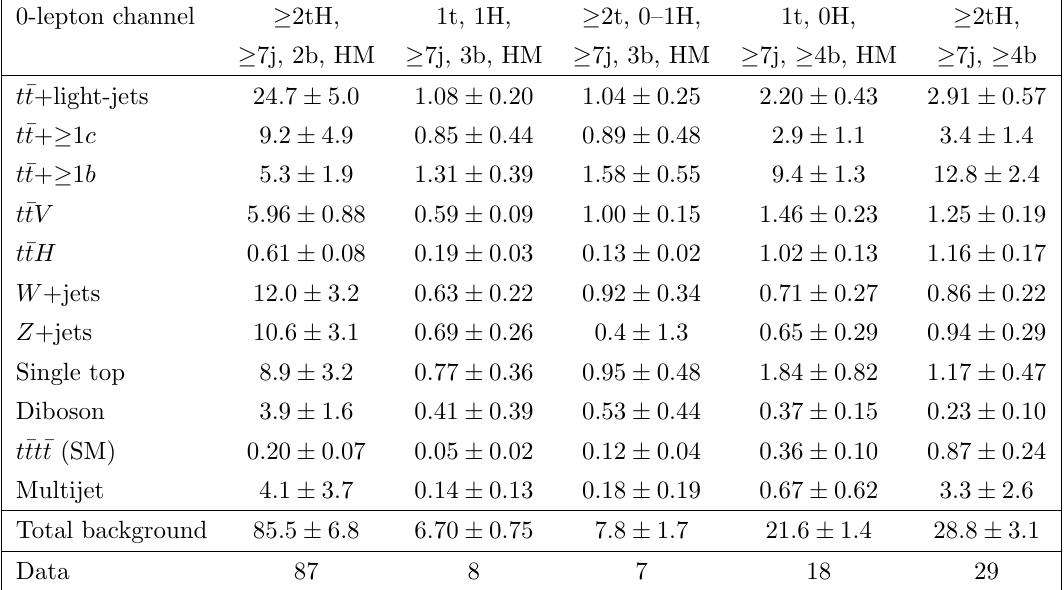
Table 7. Predicted and observed yields in the 0-lepton channel in (cid:12)ve of the most sensitive search regions (depending on the signal scenario) considered. The background prediction is shown after the combined (cid:12)t to data in the 0-lepton and 1-lepton channels under the background-only hypothesis. The quoted uncertainties are the sum in quadrature of statistical and systematic uncertainties in the yields, computed taking into account correlations among nuisance parameters and among